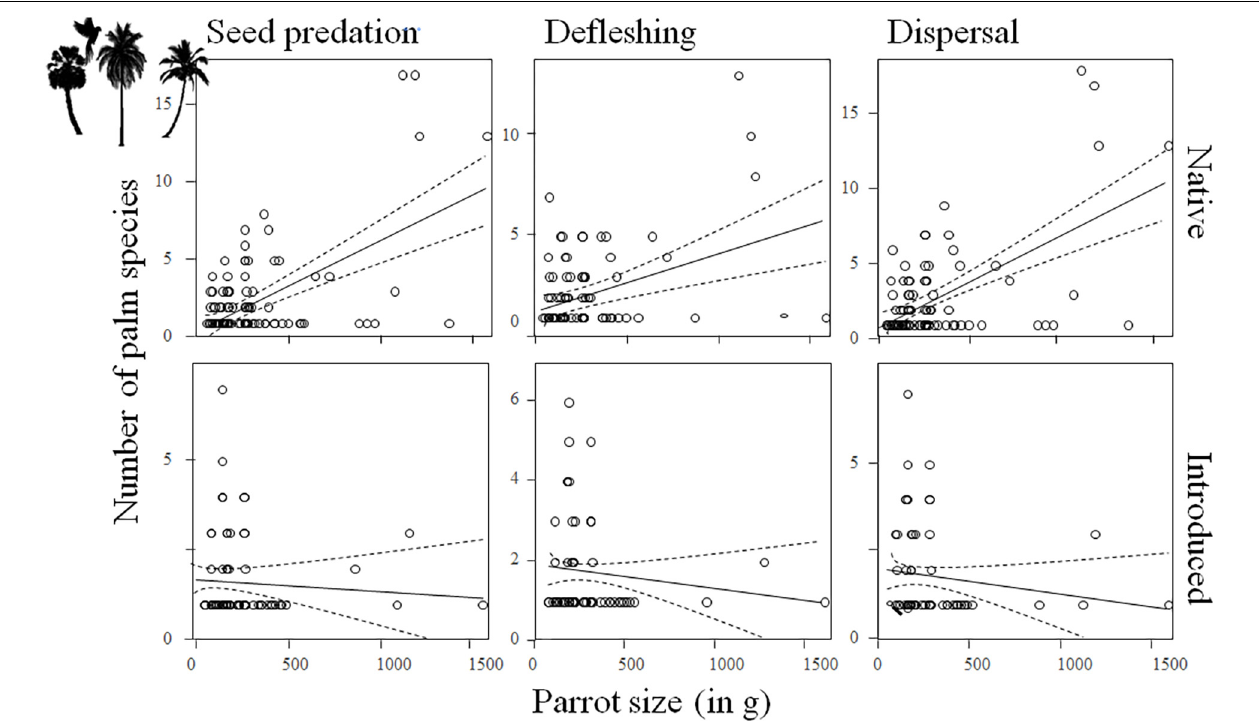
FIGURE 5 | Number of palm species interacting with parrots (i.e., seed predation, defleshing, and dispersal) differing in size (measured as body mass) across the main biogeographic realms of the world, considering whether the palm species was in its native or introduced range.